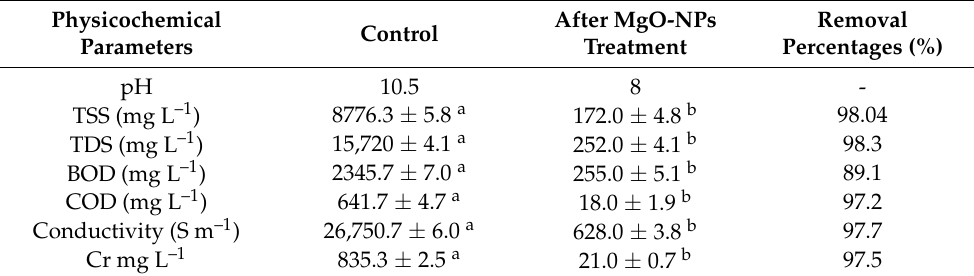
Table 2. Physicochemical characterization and chromium ion adsorption from tanning effluent by